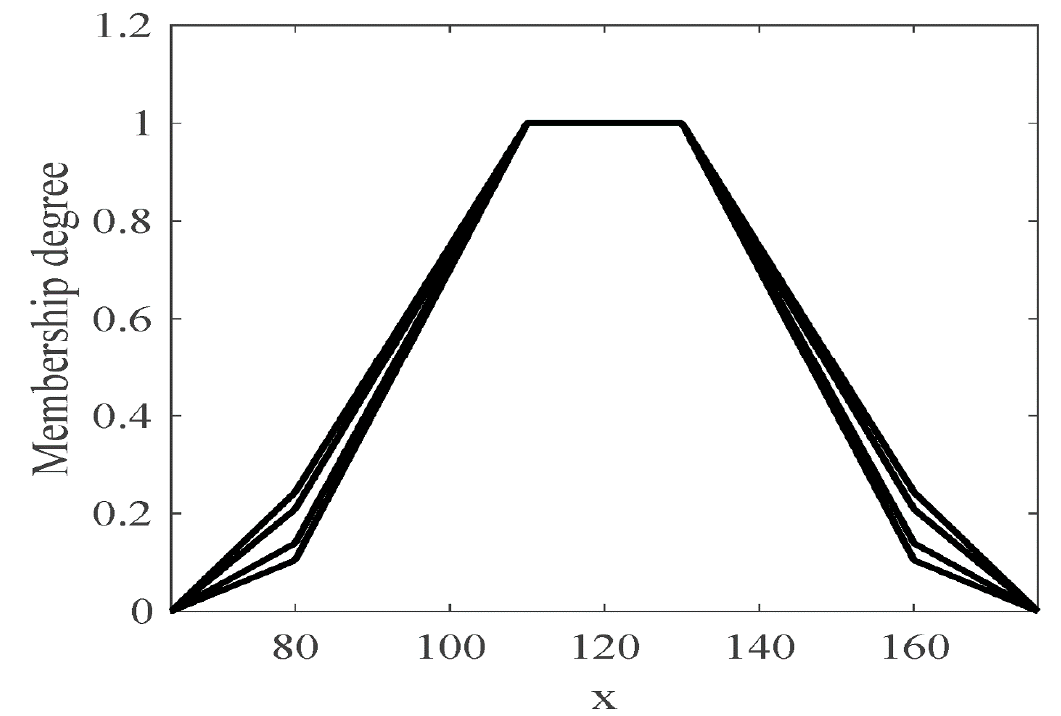
Figure 2. Graphical representation of a Trapezoidal ST2 MF.